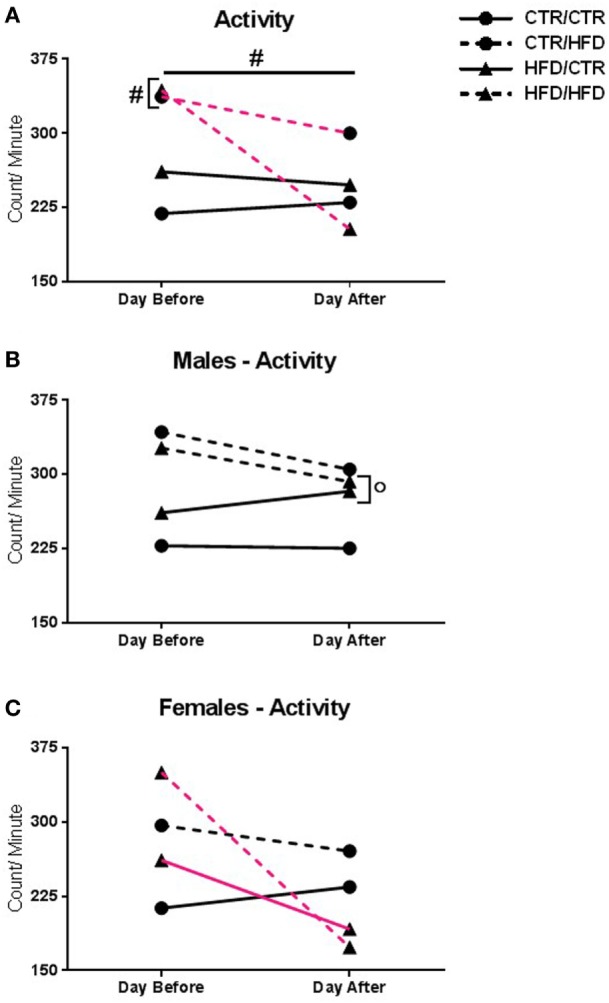
(A) Activity level was reduced the day after the behavior test in all offspring (F1,31 = 5.879, p = 0.021). Postweaning high-fat diet (HFD) increased activity (F1,31 = 8.701, p = 0.006). There was an interaction with day and postweaning diet (F1,31 = 4.868, p = 0.035), with postweaning HFD increasing activity the day before the test (F1,31 = 15.007, p = 0.001). Compared to their pre-test levels, postweaning HFD-exposed animals decreased activity after the test (F1,31 = 7.327, p = 0.011). (B) There was an interaction with day, gender, and maternal diet (F1,31 = 4.749, p = 0.037). After the test, maternal HFD males showed increased activity compared to females (F1,31 = 9.749, p = 0.004). (C) The interaction also showed that maternal HFD females had decreased activity compared to pre-test levels (F1,31 = 21.016, p = 0.00007), but not from controls (F1,31 = 2.957, p = 0.096). Data shown as mean ± SEM. # denotes a postweaning diet effect and ° denotes a gender difference, p < 0.05. Magenta lines indicate significant difference of indicated diet group between days, p < 0.05. Symbols adjacent to data points indicate significant difference on that day only, p < 0.05. Sample sizes are as follows: Day before: CTR/CTR n = 15 (n = 6 males; n = 9 females), CTR/HFD n = 8 (n = 7 males; n = 1 females), HFD/CTR n = 13 (n = 8 males; n = 5 females), and HFD/HFD n = 7 (n = 2 males; n = 5 females). Day after: CTR/CTR n = 13 (n = 6 males; n = 7 females), CTR/HFD n = 7 (n = 6 males; n = 1 females), HFD/CTR n = 13 (n = 8 males; n = 5 females), and HFD/HFD n = 8 (n = 2 males; n = 6 females).